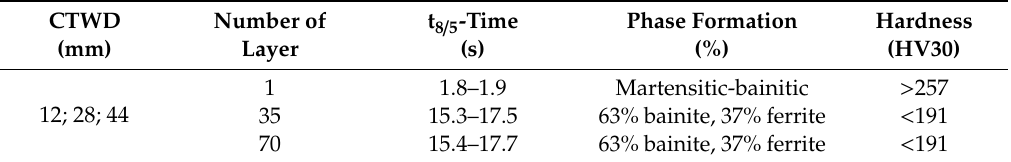
Table 3. Estimation of phase composition and hardness depending on the t 8 / 5 -time according to the CCT-diagram [37] (compare Figure